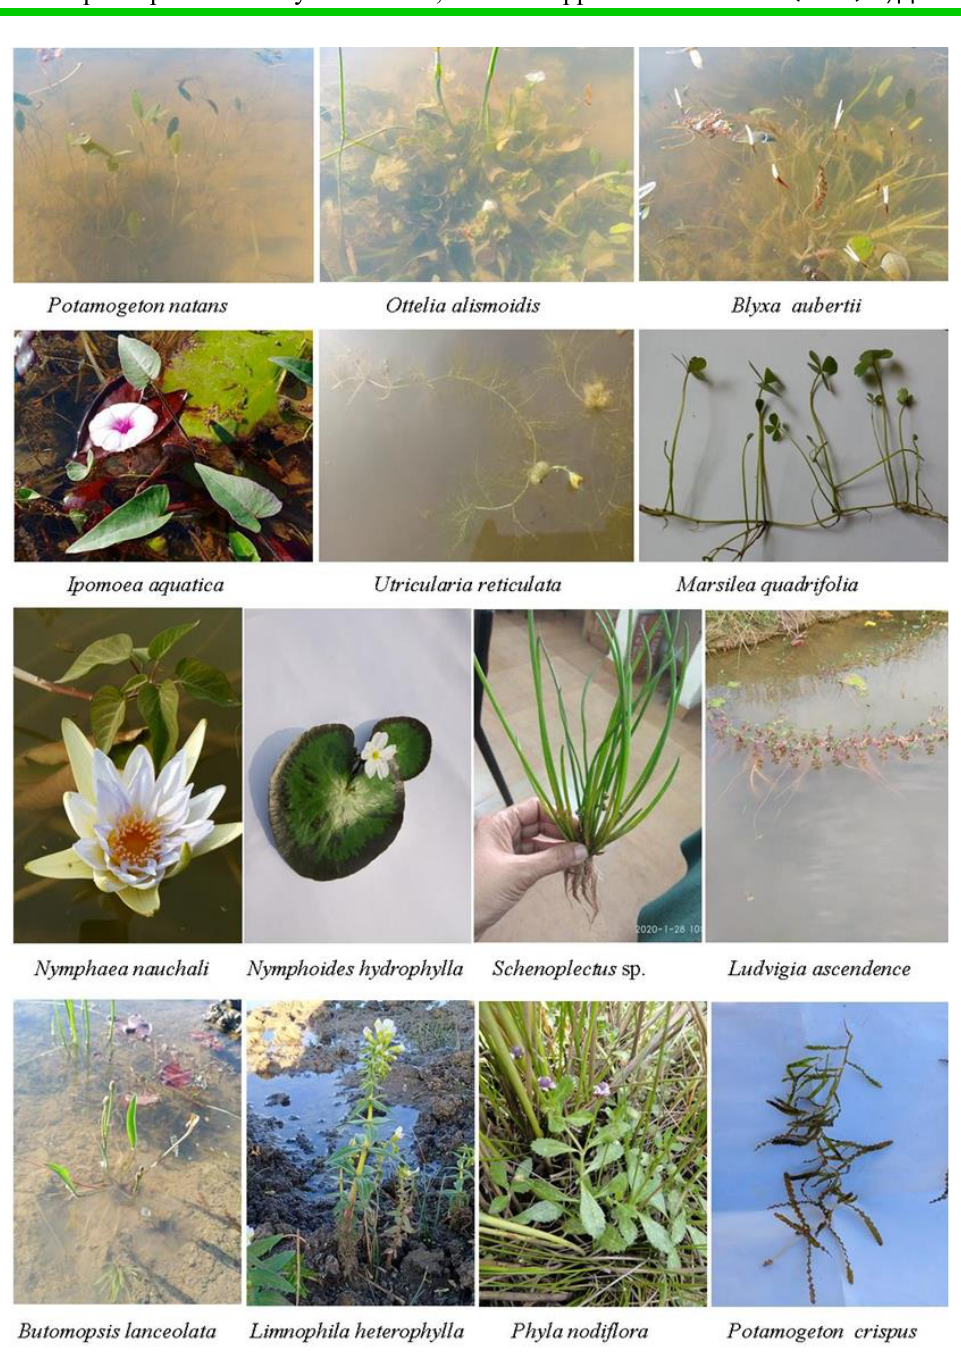
Figure 5. Some plants recorded from selected 5